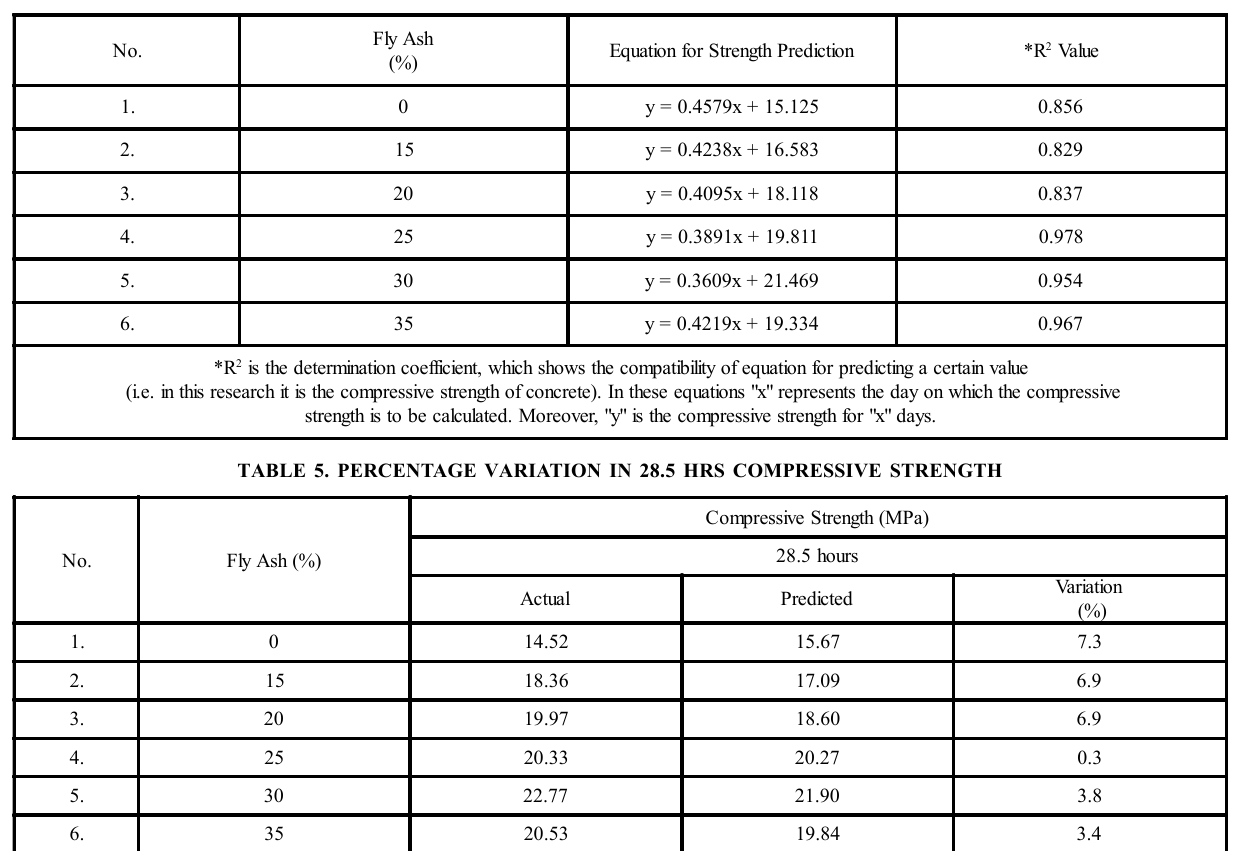
TABLE 4. LINEAR REGRESSION EQUATIONS FOR DIFFERENT FLY ASH PERCENTAGE